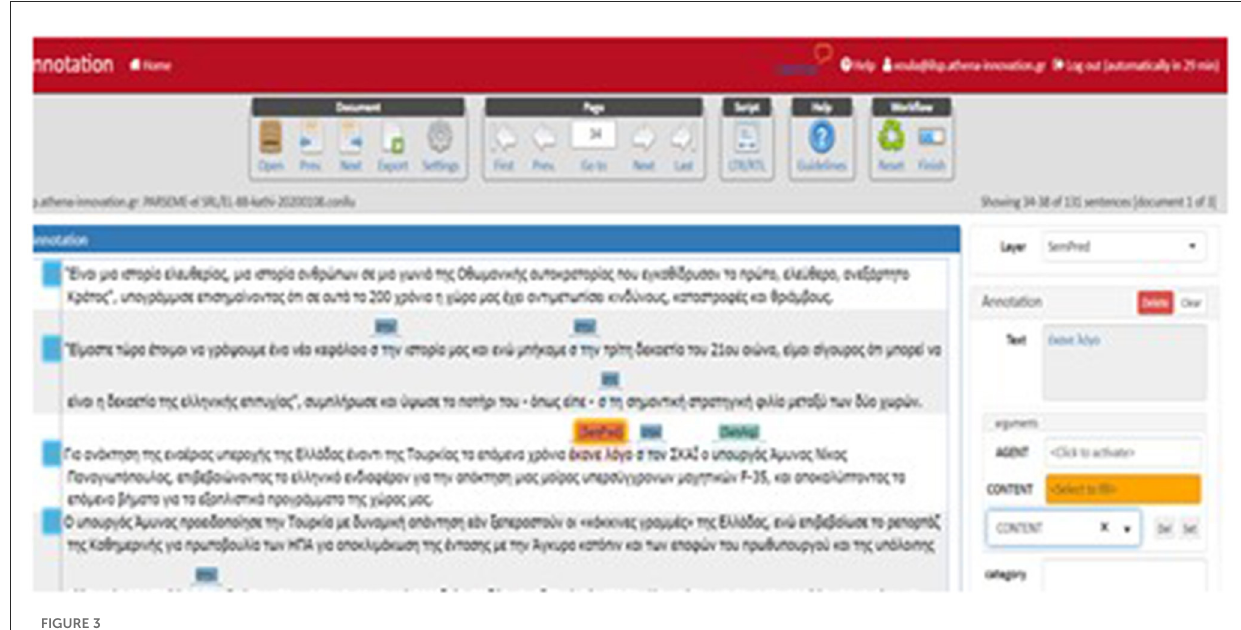
FIGURE3 SRL annotation of VMWEs in WebAnno.